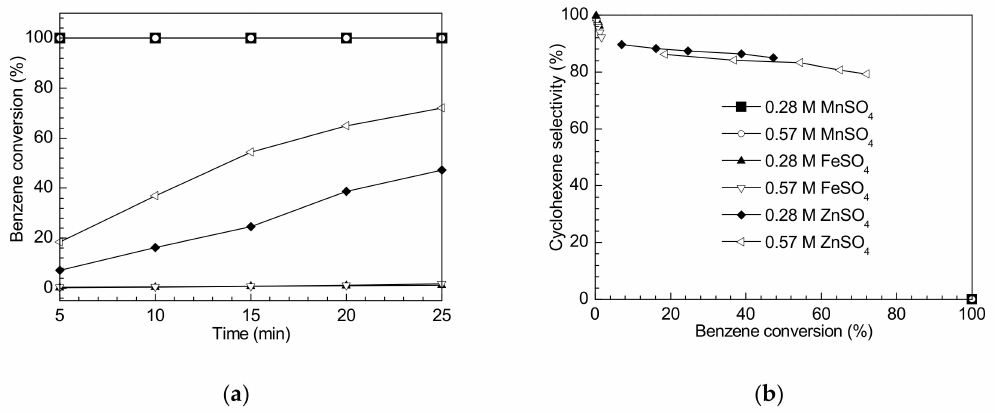
Figure 6. Catalytic activity towards benzene conversion and cyclohexene selectivity